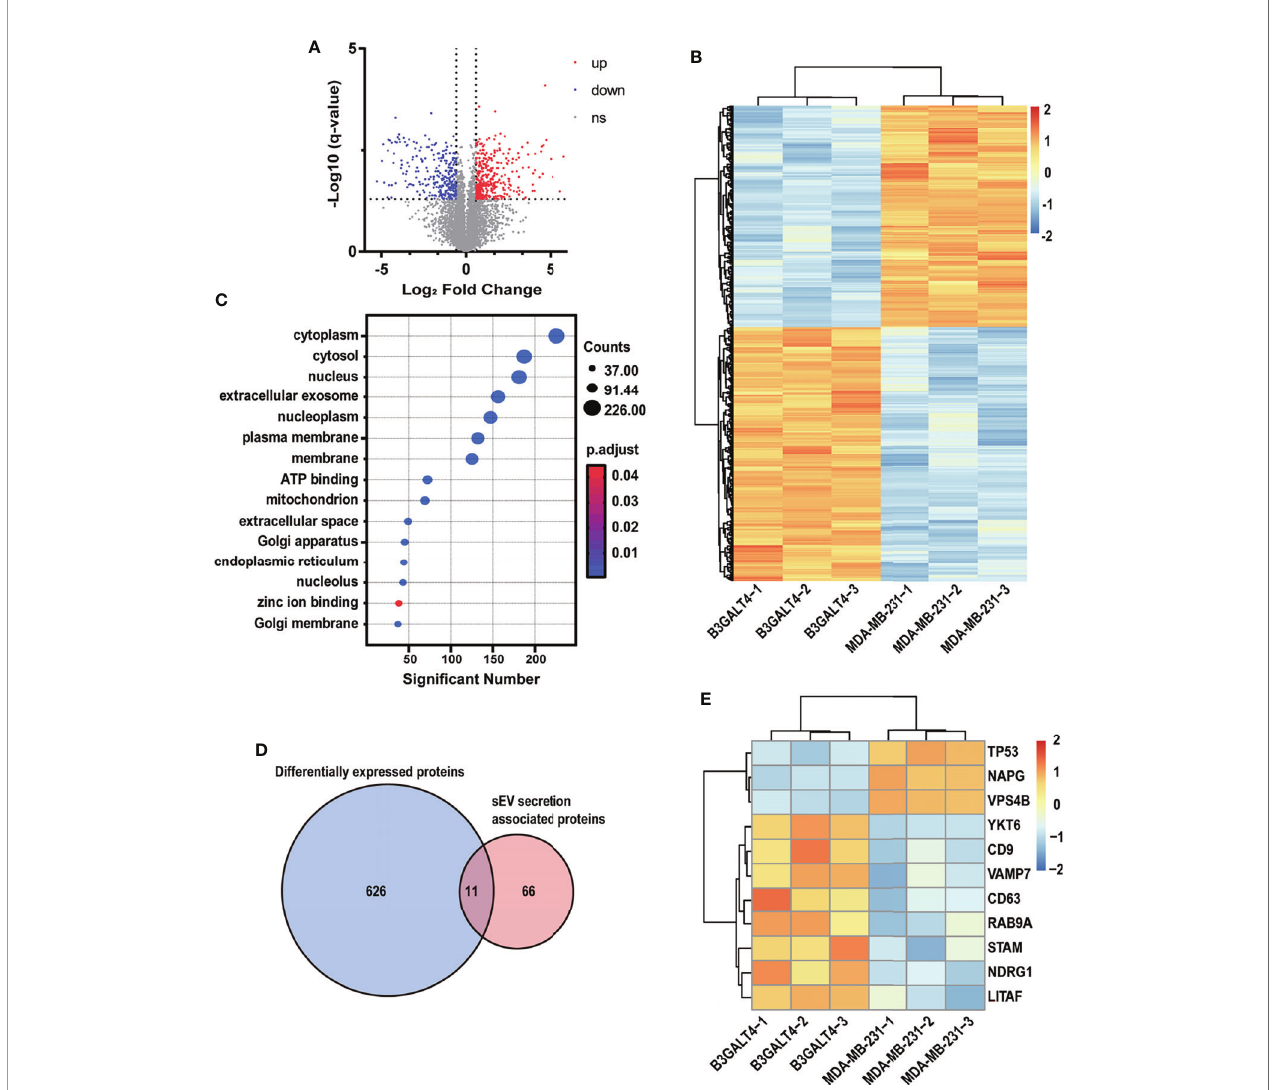
FIGURE 4 | Proteomic analysis of parental and B3GALT4-transfected MDA-MB-231 cells. (A) Volcano plot of expression pattern of identi fi ed proteins in parental and B3GALT4-transfected MDA-MB-231 cells. The -log10 ( q -value) is plotted against the log2 (fold change: B3GALT4-transfected cells vs. parental cells) using the cutoffs of fold change >1.5, fold change < 0.67, and q -value < 0.05. Red, signi fi cantly upregulated expression. Blue, signi fi cantly downregulated expression. (B) Expression pattern of DEPs identi fi ed in parental and B3GALT4-transfected MDA-MB-231 cells, B3GALT4-1/-2/-3 and MDA-MB-231-1/-2/-3 represent three biological replicates. Red, upregulated expression. Blue, downregulated expression. (C) Enriched Gene Ontology analysis of DEPs. (D) Venn diagram of DEPs and sEV secretion-related proteins. (E) Heatmap of DEPs involved in sEV secretion process. Red, upregulated expression. Blue, downregulated expression. Ns, no signi fi cant differential